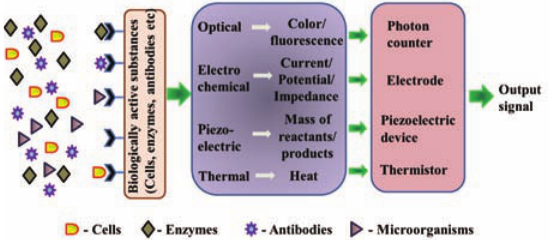
Fig. 1 Components of a biosensor (adapted from Rana et al.,